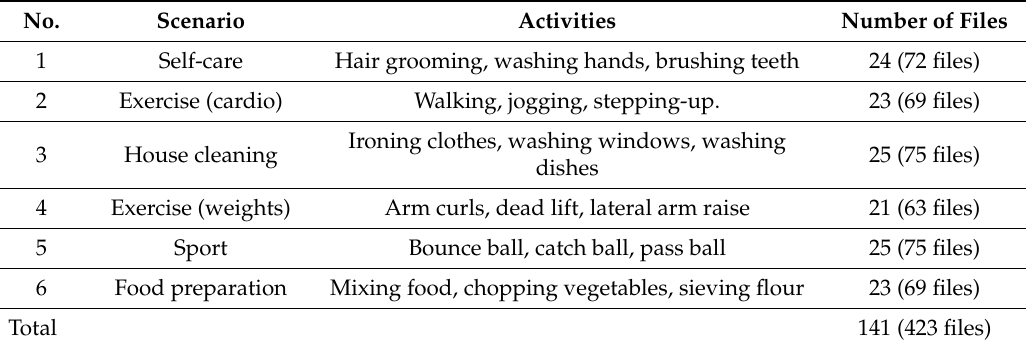
Table 2. Scenarios and activities performed